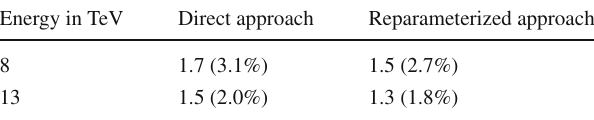
Table 5 Mean errors on the LHC χ 2 prediction for both approaches in SCYNet Energy in